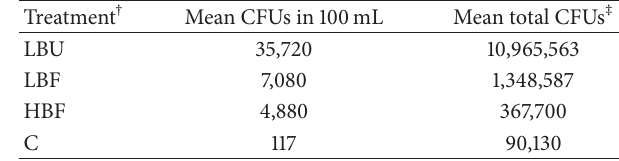
Table 2: Plant available nitrogen (PAN) and total phosphorus (TP) included in mineral fertilizer and biosolids treatments.